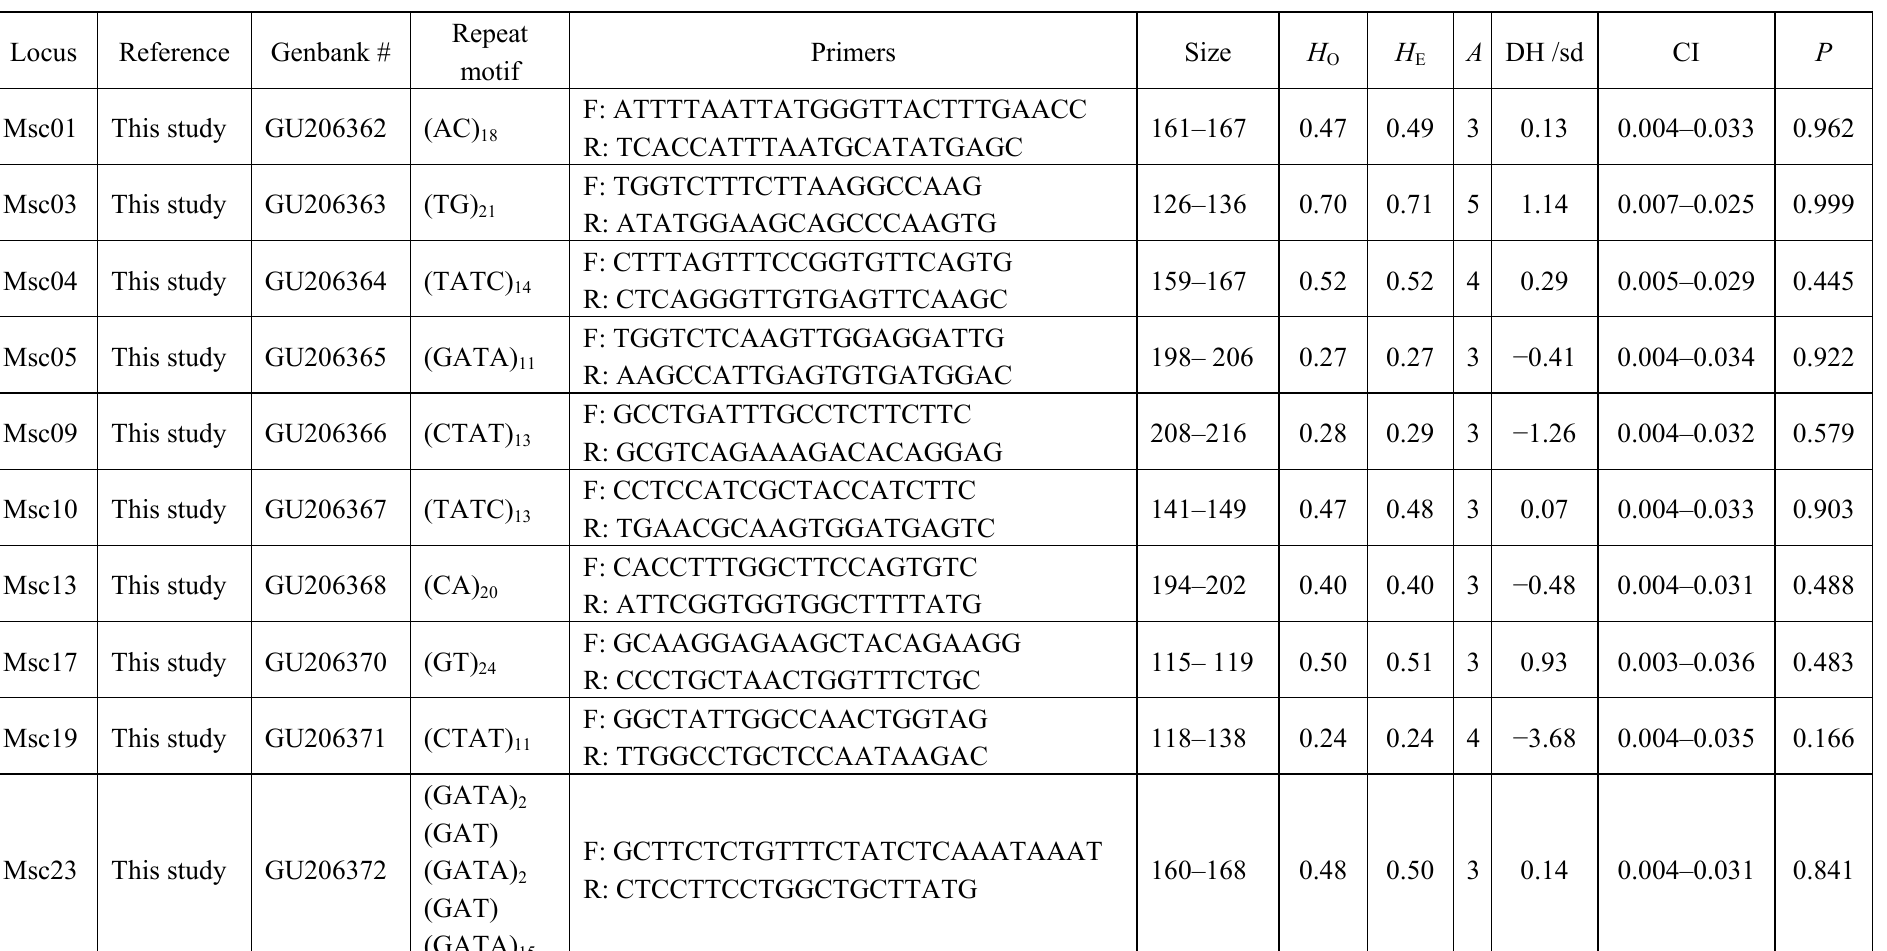
Table 2. Polymorphic microsatellite loci, including the size of the alleles, observed ( H alleles ( A ), and a test for a population bottleneck (DH/sd). We also include LOSITAN results, including the 95% confidence intervals (CI) for values, given heterozygosity of the loci, and the probability ( P ) that the simulated F simulated F ST